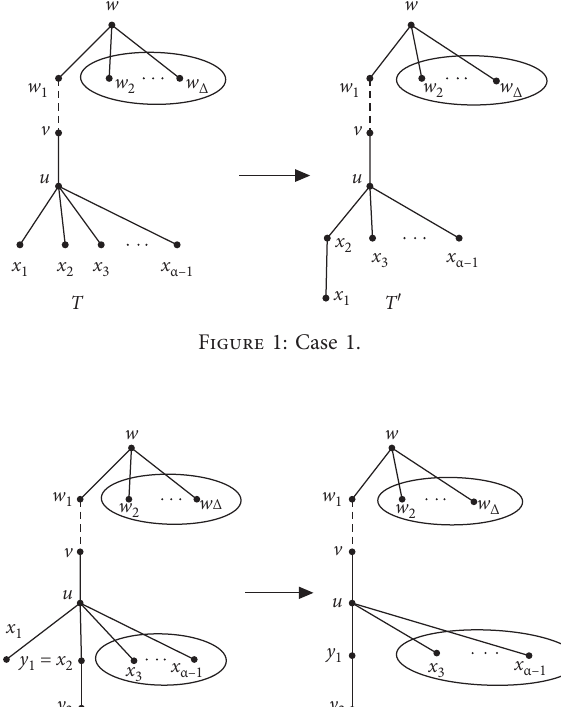
Figure 2: Case 2.